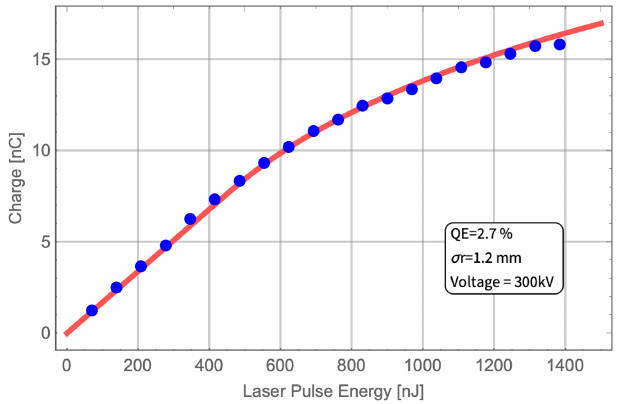
FIG. 9. Space charge limit for the EIC polarized gun with a 6 mm diameter laser spot. Blue dots are measurement and the red curve is the fitted